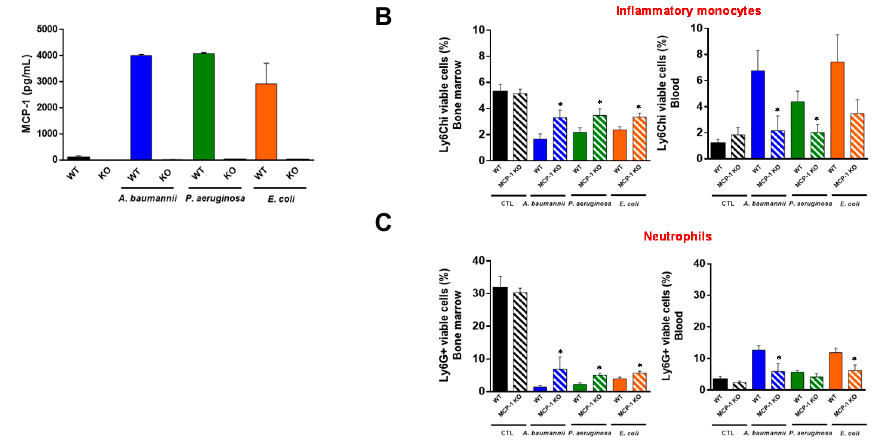
Figure 2. Role of MCP-1 in the bone marrow immune cells’ migration to the blood during bacterial infection. ( A ) Wild-type (WT) and MCP-1 knockout (KO) mice were in-